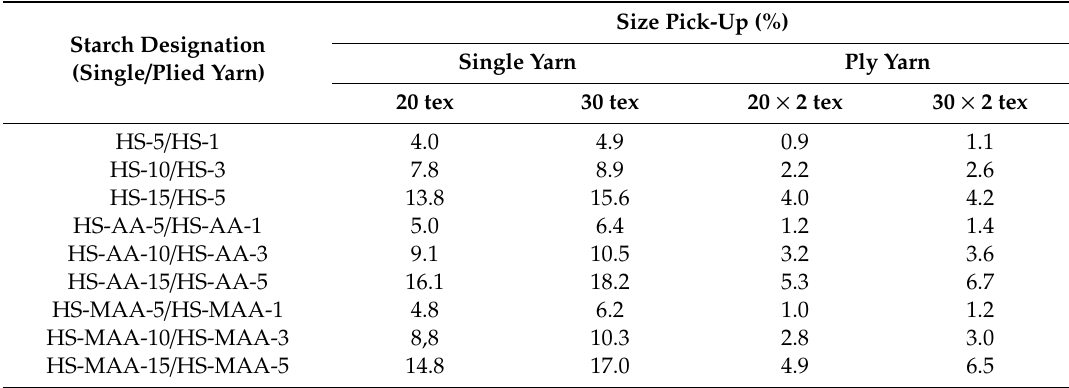
Table 6. Size pick-up on the yarn sized with grafted hydrolyzed